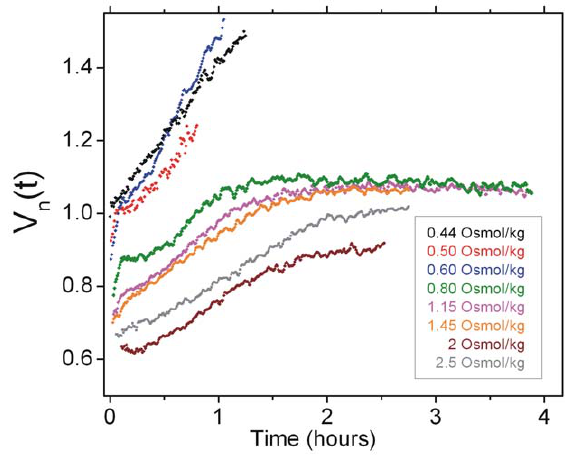
Figure 3. Volume recovery is complex and required for growth. Averaged recovery traces shown for different shock magnitudes (V n (t)). The initial 10 minutes of data is recorded at 1 Hz frame rate, subsequent data is recorded at a frame every 30 seconds. For each cell in a given data set, the recovery trace was normalized by the initial volume, aligned at the time of hyperosmotic shock and resampled every 30 seconds. The average trace was computed from these normalized and aligned data sets. The following conditions are shown: 0.44 Osmol/kg data (N=9), 0.5 Osmol/kg (N=4), 0.6 Osmol/kg (N=22), 0.8 Osmol/kg (N=6), 1.15 Osmol/kg (N=28), 1.45 Osmol/kg (N=16), 2 Osmol/kg (N=12) and 2.5 Osmol/kg (N=5).